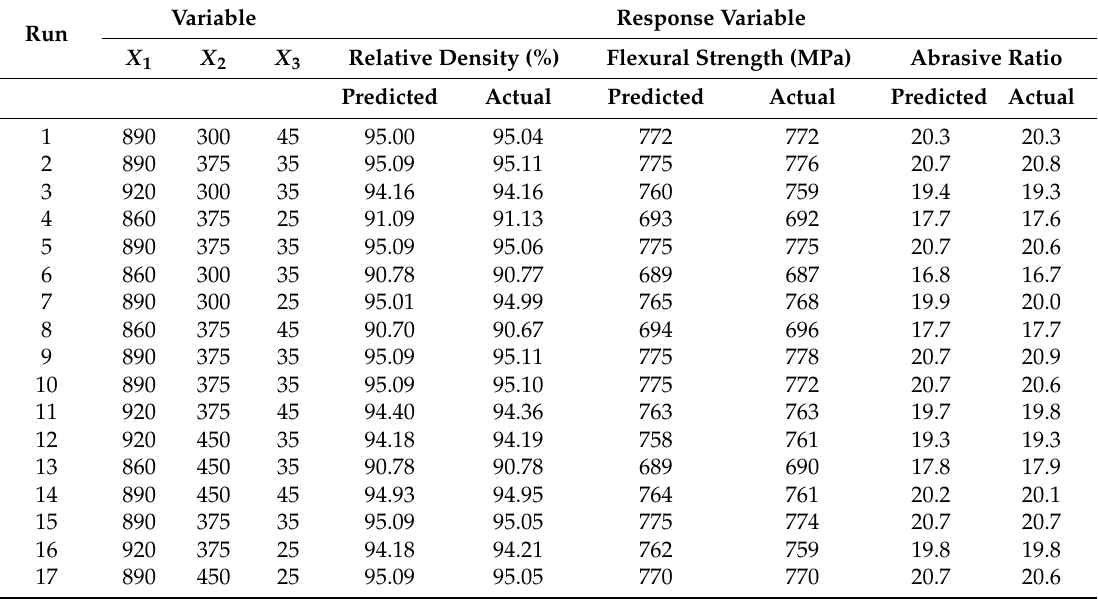
Table 3. Experimental design and results of